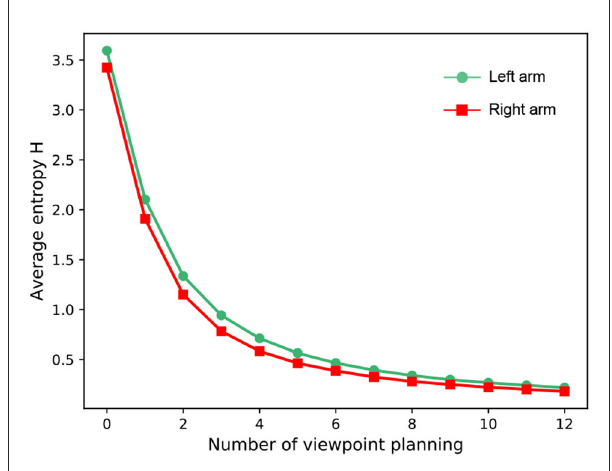
FIGURE6 The average entropy over the whole test dataset. The experiment is implemented with our VP model.